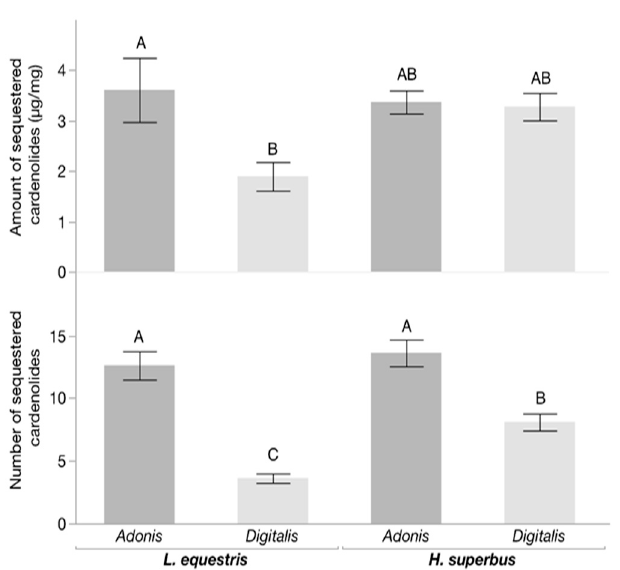
Figure 4. Quantity and number of different sequestered cardenolides by milkweed bug larvae. Bars represent the means ± SE of the concentration ( μ g/mg) ( top ) and the number of structurally different cardenolides sequestered ( bottom ) by L. equestris (n = 8 per treatment) and H. superbus (n = 8–10 per treatment) raised on the seeds of either Adonis vernalis or Digitalis purpurea . Different letters above bars indicate significant differences.